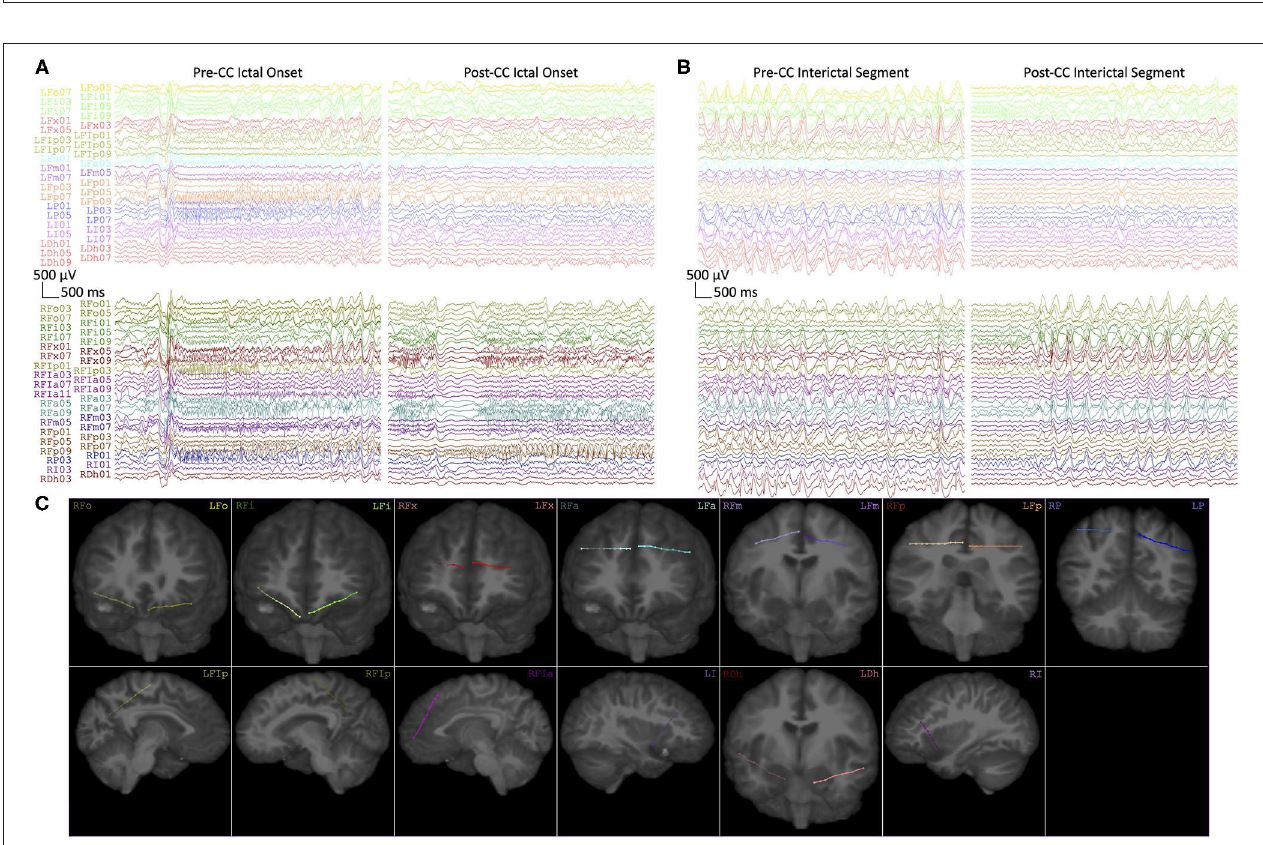
FIGURE 3 | channels recruited to a representative pre-CC seizure (Subject 1, seizure 2) as a function of the recruitment threshold, using the low-frequency line length metric. The bar graph on the right shows the mean percentage of the first eight recruited channels in the more-pathologic hemisphere in red, and in the less-pathologic hemisphere in blue, from the domain of thresholds between 2.00 and 5.00. The horizontal dashed line represents the chance conditions of 50% and the percentage of electrodes on the more-pathologic side (almost the same in this subject). Here, the portion of channels on the more-pathologic (correct) side is considerably less than that on the less-pathologic side—low-frequency line length does not correctly lateralize this pre-CC seizure. (C) Same as (B) but for post-CC seizure 4. Here, there is a strong suggestion of lateralization to the correct hemisphere, as seen in the preponderance of channels from the more-pathologic hemisphere (red squares) among the first eight channels recruited across the domain of thresholds. (D) Maximum likelihood estimates and confidence intervals (corresponding to p < 0.05) of the fraction of the first eight recruited channels from the more- and less-pathologic hemispheres in red and blue, respectively, across pre-CC seizures using phase-locked high gamma, high gamma amplitude and low-frequency line length metrics in each of the three subjects. Fifty-percent and channels-on-correct-side chance levels shown as dotted lines. (E) Same as (D) but for post-CC seizures. * p < 0.05, Bonferroni corrected for N = 3 subjects, relative to the stricter of the two chance performance levels. † p < 0.05, uncorrected × wrong side, p < 0.05, uncorrected, vs. at least one chance criterion. Pre-CC, pre-corpus callosotomy; Post-CC, post-corpus callosotomy.